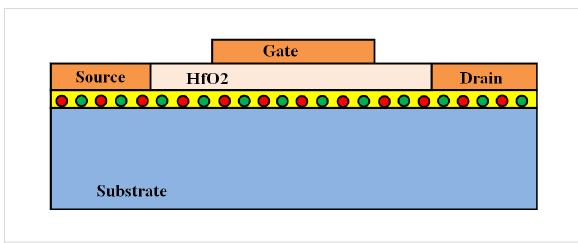
Figure 3: Schematic representation of the simulated device structure. The gate insulator is assumed to be 2.5 nm thick HfO 2 ( κ = 25). Source and drain contacts are heavily doped extensions of the channel without